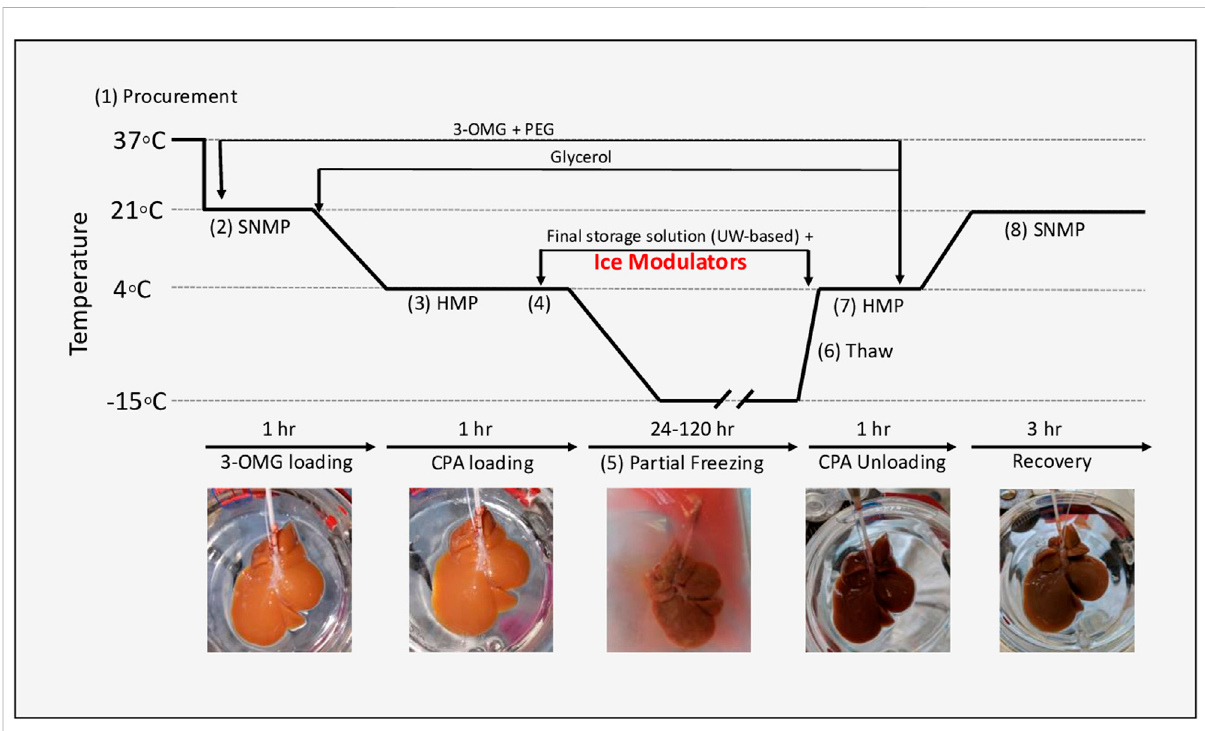
FIGURE 1 Experimental design of partial freezing, in eight consecutive steps: 1 ) liver procurement, 2 ) preconditioning during SNMP, 3 ) CPA preloading during hypothermic machine perfusion (HMP), 4 ) loading of fi nal storage solution and ice modulators during HMP, 5 ) partial freezing of rat liver, 6 ) thawing of rat liver, 7 ) unloading of CPAs during HMP, and 8 ) functional recovery of frozen rat livers during